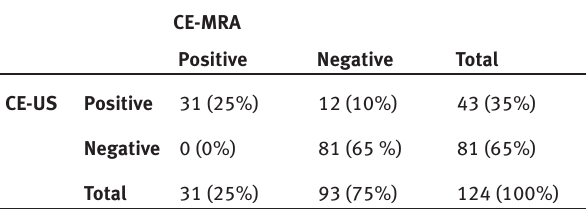
Table 2: Comparison of findings on CE-MRA with findings on